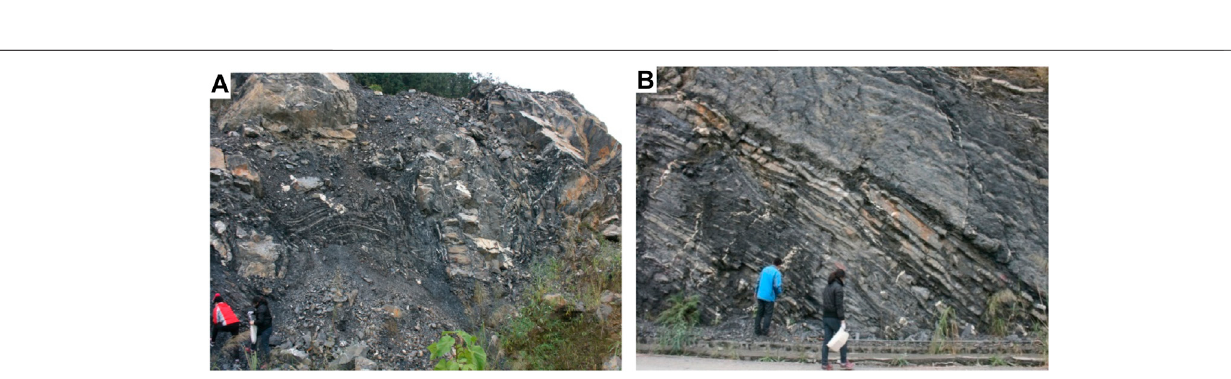
FIGURE 10 | Permeability difference of limestone in different strata of Upper Paleozoic in the Qiannan area.